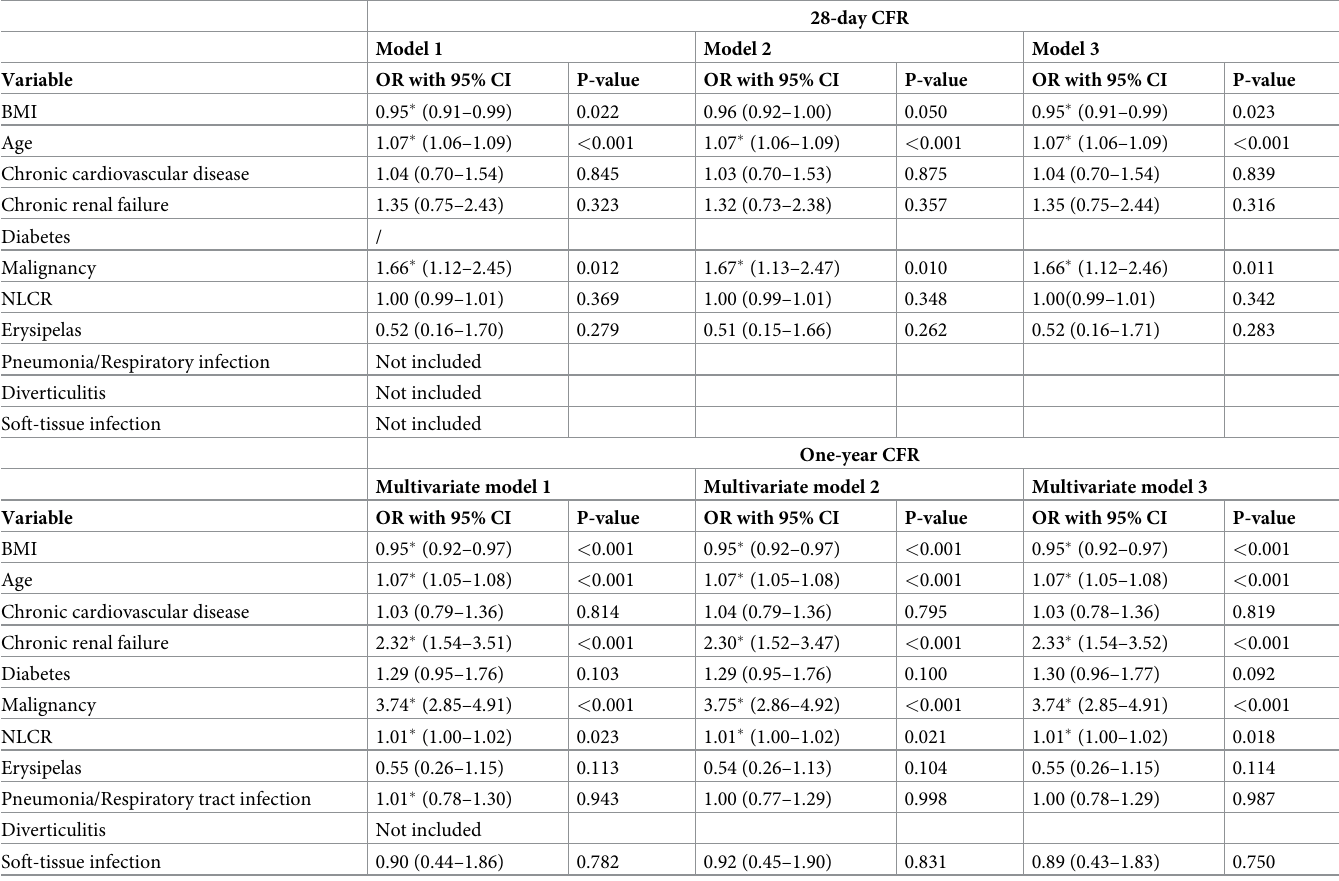
Table 5. Multivariate logistic regression models after multiple